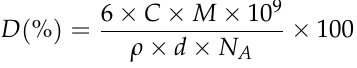
Figure 5. Cyclohexane conversions, selectivities of benzene and H 2 purities with M/CN (M = Pt, Pd, Rh and Ir) catalysts at ( a ) 180 °C, ( b ) 190 °C, ( c ) 200 °C and ( d ) 210 °C.